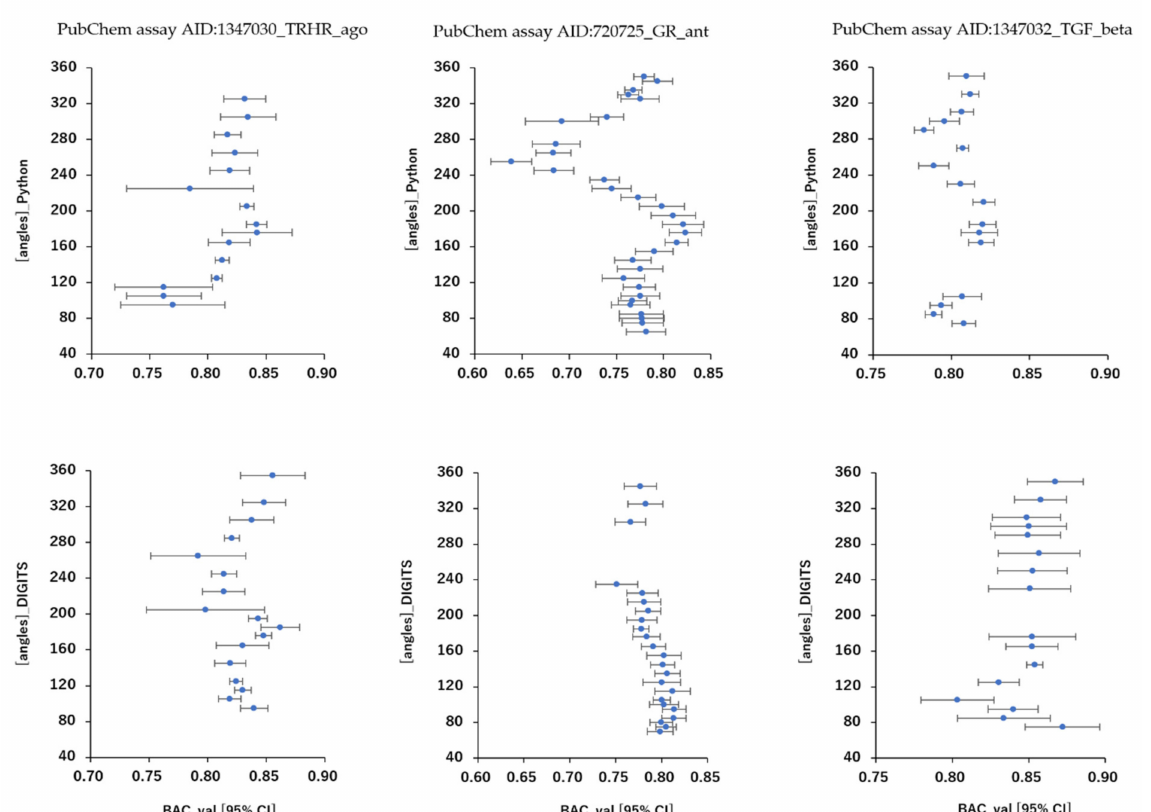
Figure 4. Differences in mean BAC levels shown as dots with 95% confident interval (95% CI) as error bars with angles in DeepSnap-DL using TensorFlow and DIGITS of prediction models of the glucocorticoid receptor (PubChem assay AID:720725_GR_ant), TGF-beta/Smad (PubChem assay AID:1347032_TGF_beta_ant), and agonist of the thyrotropin-releasing hormone receptor (PubChem assay AID:1347030_TRHR_ago) in the validation dataset; n = 3. The highest prediction performance values of PR_AUC on the valid dataset for the an- gles and data-split ratios were 0.660 at 176 ◦ and train:valid:test = 7:1:2 in AID:720725_GR_ant, 0.194 at 176 ◦ and train:valid:test = 3:1:2 in 1347030_TRHR_ago, and 0.453 at 176 ◦ and train:valid:test = 3:1:1 in 1347032_TGF_beta_ant (Figures S9 and S10; Table 3). In addition, the highest prediction performance values of F on the valid dataset for the angles and data- split ratios were 0.935 at 176 ◦ and train:valid:test = 7:1:2 in 720725_GR_ant, 0.914 at 176 ◦ and train:valid:test = 3:1:2 in 1347030_TRHR_ago, and 0.876 at 176 ◦ and train:valid:test =